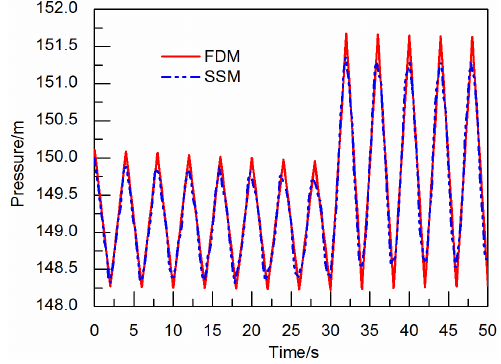
Figure 3. Method verification of pressurized conduit